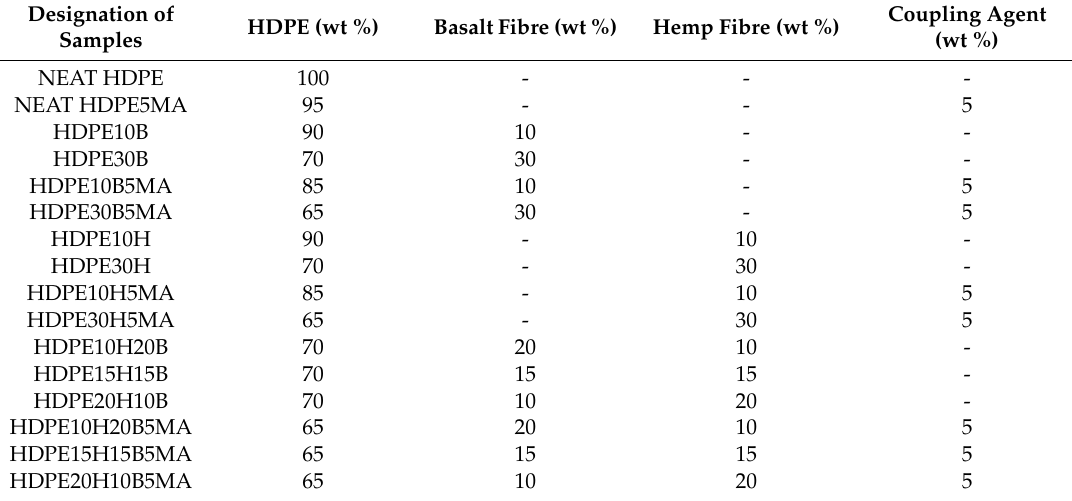
Table 1. Formulation and description of composite samples produced and